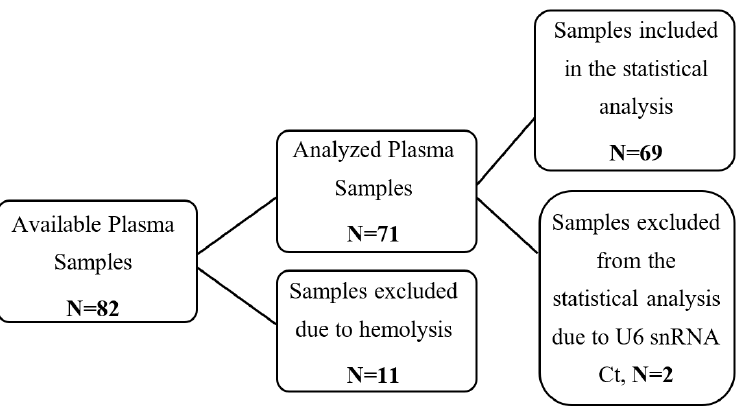
Figure 1. Flow Diagram for study participants treated with Nivolumab monotherapy.